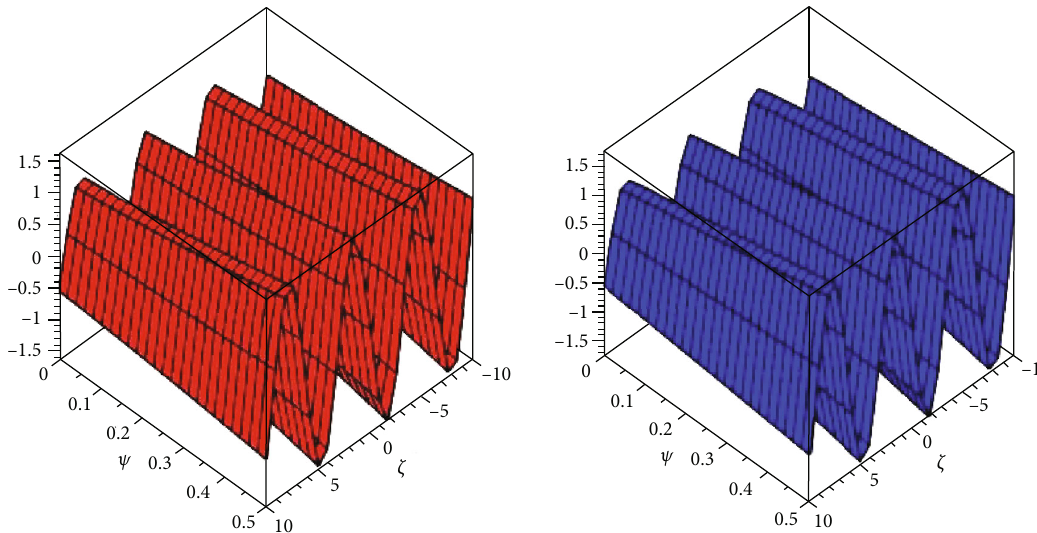
Figure 3: The YDM solution of example 1 of μ ð ζ , Ψ Þ at δ = 1 , and 0 : 8 .